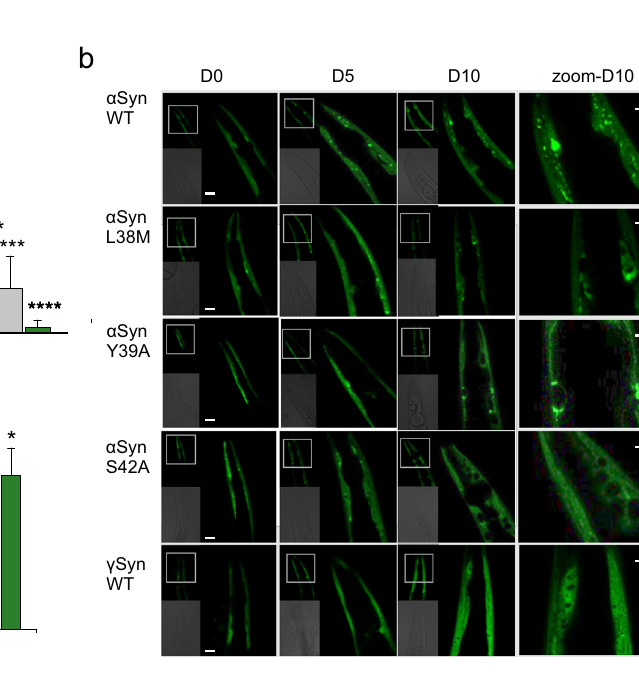
Fig. 8 | Effect of single amino-acid substitutions in α Syn and γ Syn in the body wall muscle of C. elegans . a Number of inclusions (larger than ~2 µ m 2 per